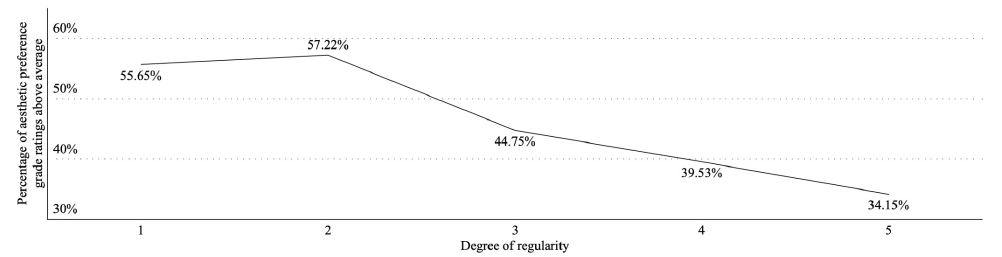
Figure 8. Percentage of aesthetic preference grade above